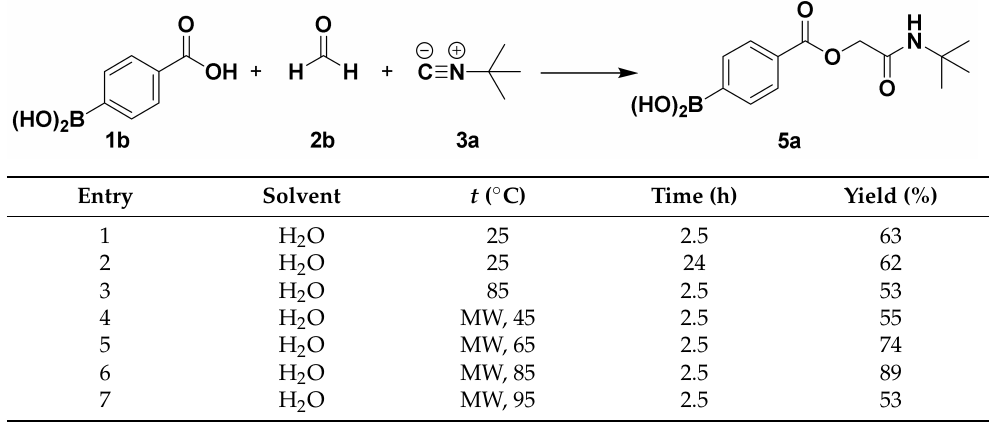
Table 2. Optimization of P-3CR using boronobenzoic acids 1 a, b